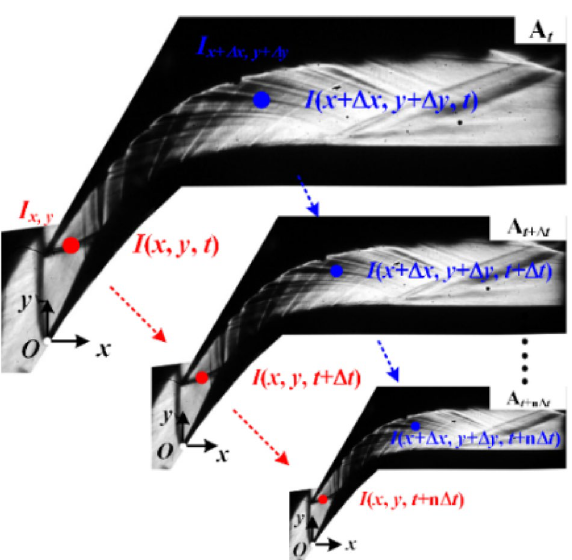
Figure 10. Method used for the time–frequency analysis of the schlieren images.